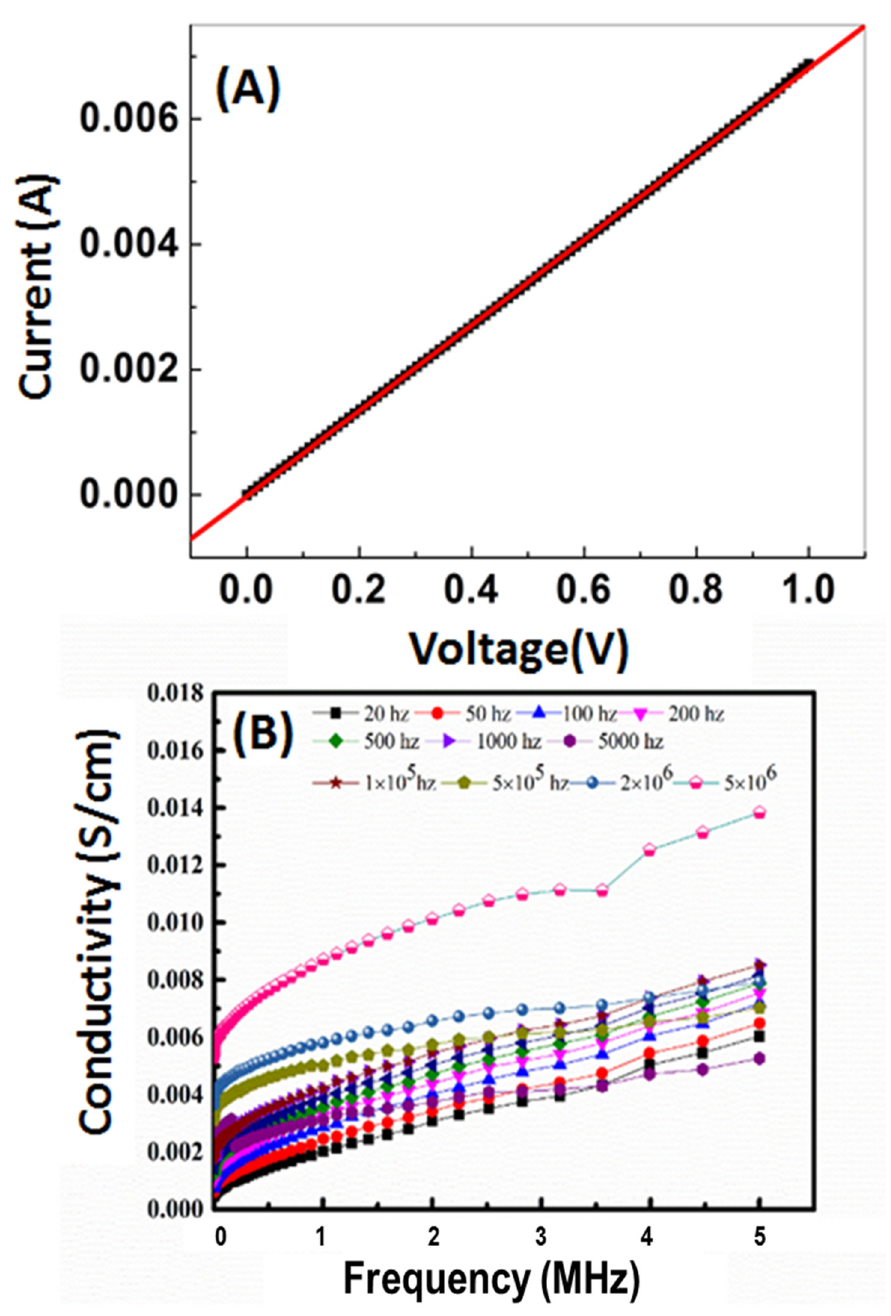
Figure 5. Electrical properties of nanocomposite; ( A ) direct current versus voltage and ( B ) frequency dependence of AC conductivity, σ ac ( ω ), at various temperatures.